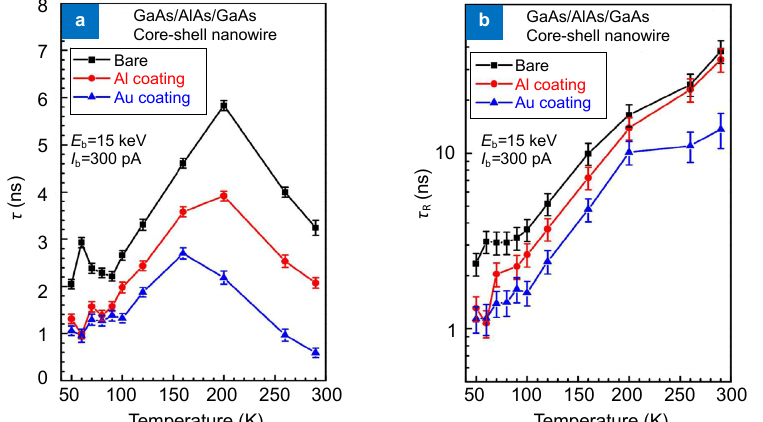
Fig. 11 | Measured carrier decay times τ ( T ) in ( a ) and radiative lifetime τ R ( T ) in ( b ) with time-resolved CL spectroscopy . Figure reproduced from ref. 76 , ACS